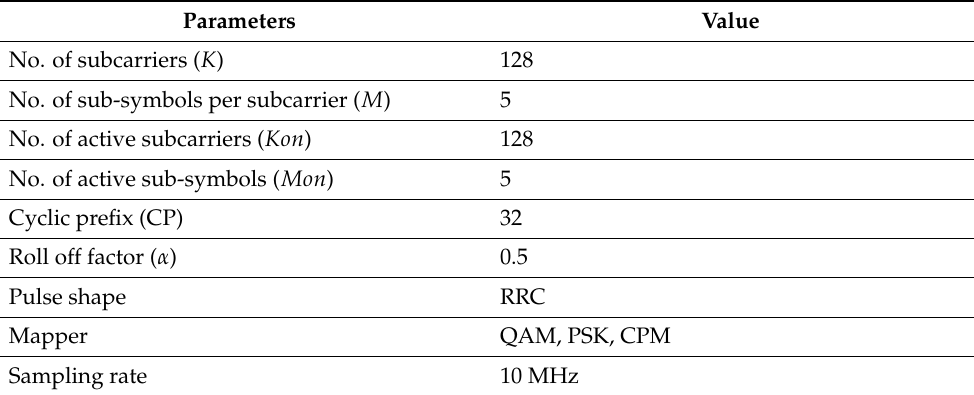
Table 1. GFDM Parameters.